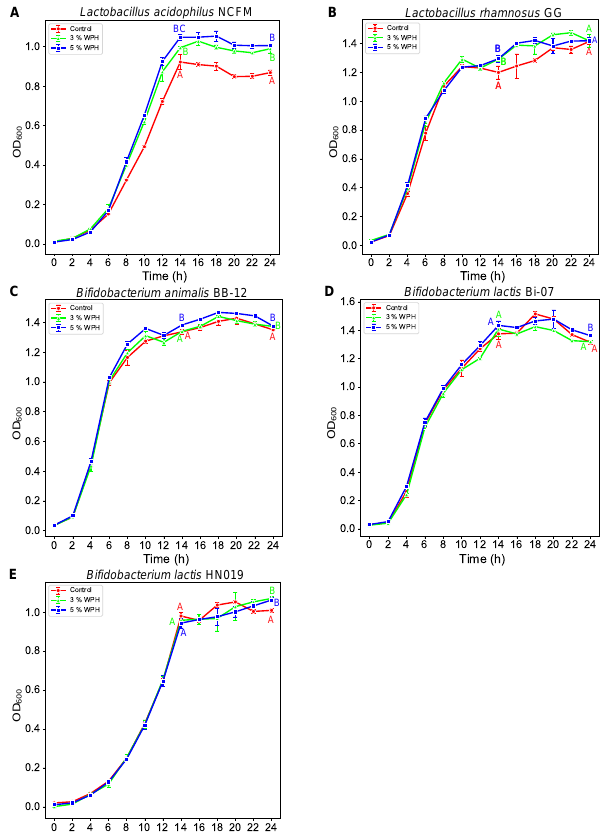
Figure 2. Growth curves of cultivated probiotics: ( A ) Lactobacillus acidophilus NCFM, ( B ) Lactobacillus rhamnosus GG, ( C ) Bifidobacterium animalis BB-12, ( D ) Bifidobacterium lactis Bi-07, ( E ) Bifidobacterium lactis HN019. Different capital superscript letters indicate significant differences ( p < 0.05) for OD 600 value in different samples (at the time point of 14 h and 24 h,